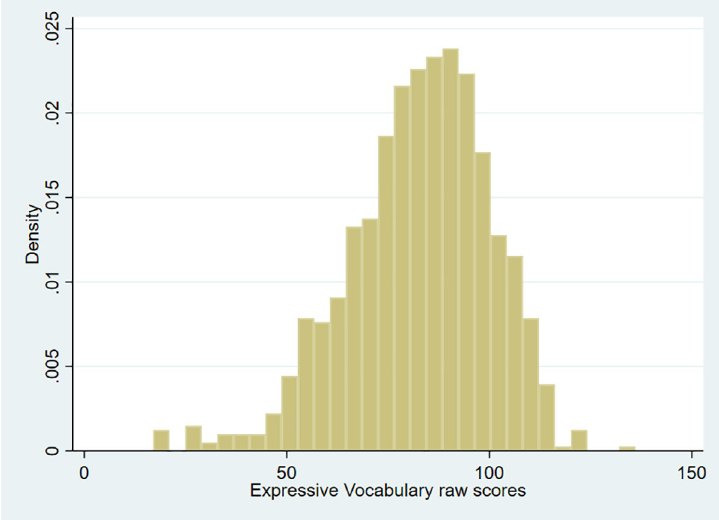
Fig 4. Distribution of the raw scores of the expressive vocabulary test for the combined Year 1 and Year 3 sample (n = 1,029).